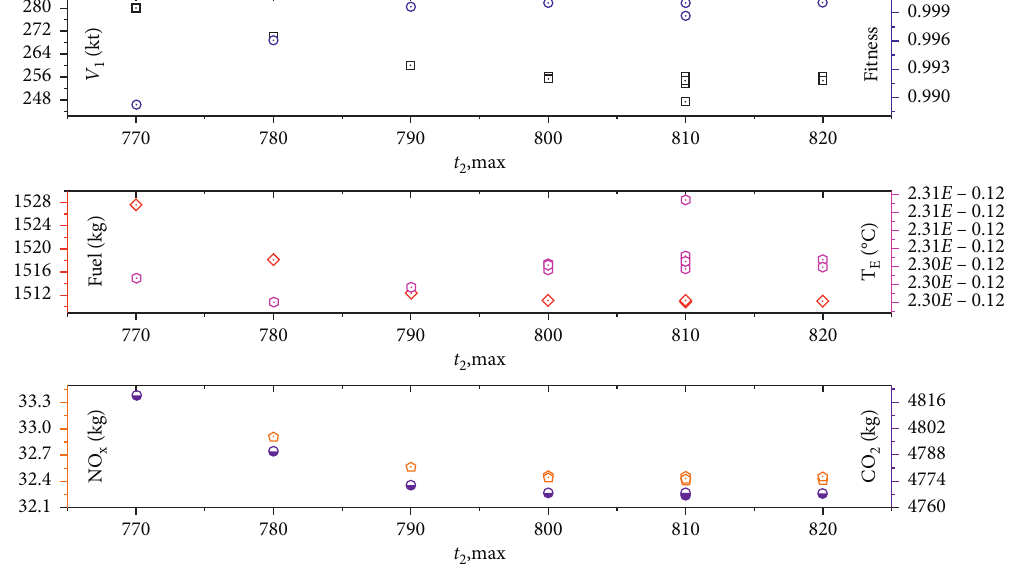
on optimization 2 , max